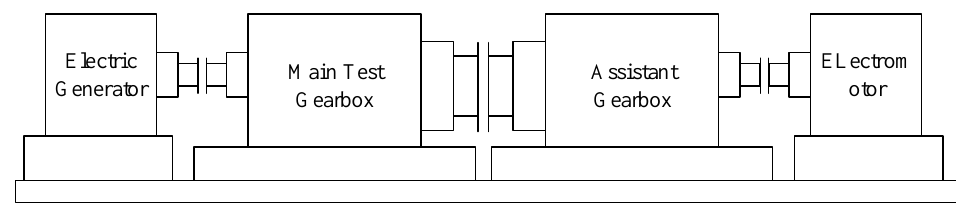
Figure 7. Schematic of the gearbox test rig.